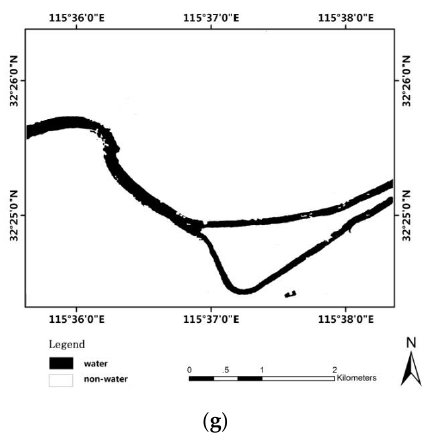
Figure 4. Segmentation results (Huai River). ( a ) SWR region generated by Figure 3d; ( b ) Manual segmentation; ( c – e ) LSW map obtained using ALG1, ALG2 and ALG3,respectively; ( f ) LSW map obtainedusing proposed method; ( g ) LSW map obtained after post-processing.